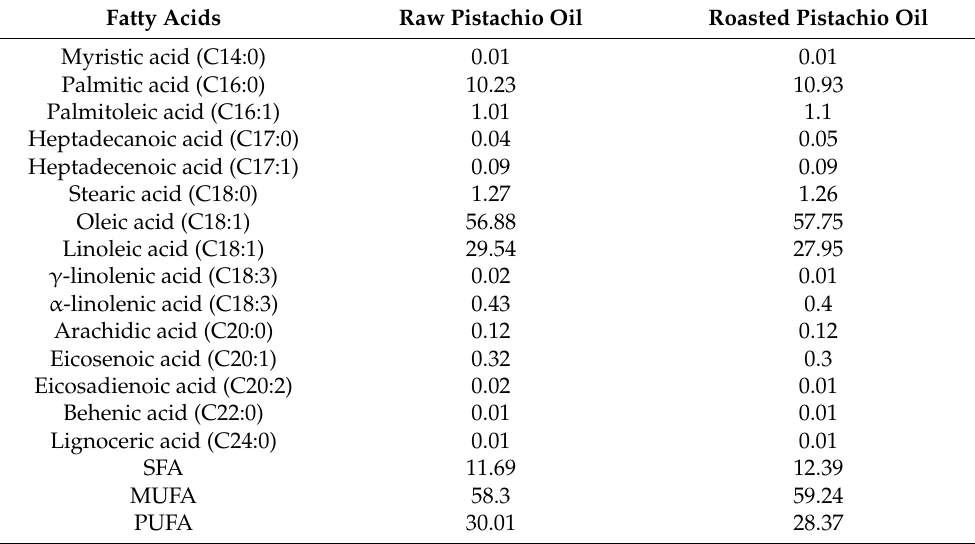
Table 2. Fatty acid composition (expressed as %) of oils extracted from pistachio samples.